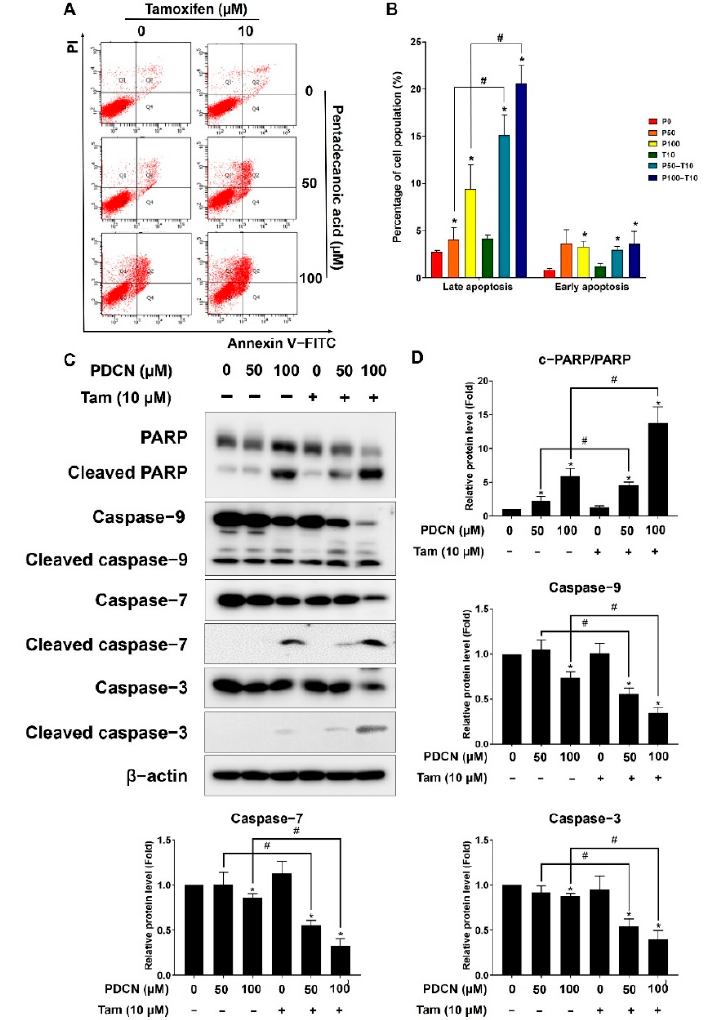
Figure 5. Pentadecanoic acid combined with tamoxifen induces apoptosis. ( A , B ) AnnexinV/PI staining was used to determine the apoptotic population following treatment with pentadecanoic acid or tamoxifen alone in combination for 48 h. ( C , D ) The levels of apoptosis markers were assessed